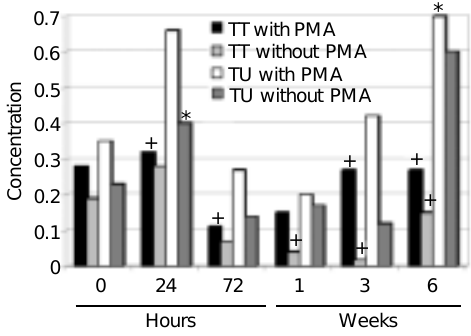
Figure 3. Functional status of macrophages present in the bronchoalveolar lavage of thalid- omide-treated (TT) and untreated (TU) Swiss mice. The assay was based on spontaneous (without PMA) and induced (with PMA) H 2 O 2 release. Data are reported as medians. + P < 0.05 compared to the infected untreated group (Kruskal-Wallis test). *P < 0.05 compared to the untreated in- fected group (Kruskal-Wallis test). PMA = phorbol